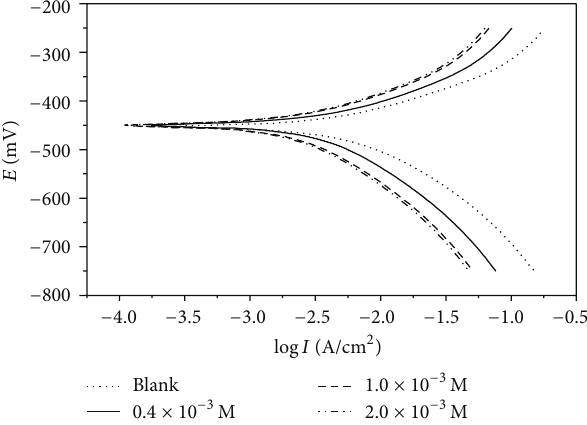
Figure 8: Polarization curves for mild steel in 1N H 2 SO 4 in the absence and presence of different concentration of inhibitor